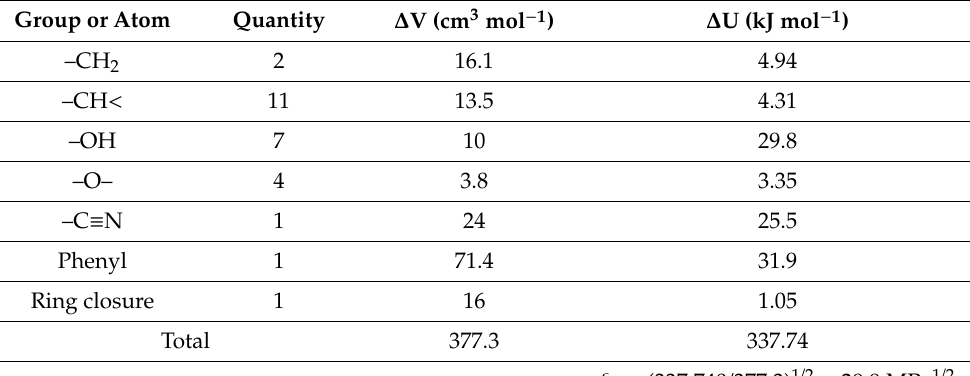
Table 2. Estimation of the solubility parameter of amygdalin by Fedor’s method [34]. Group or